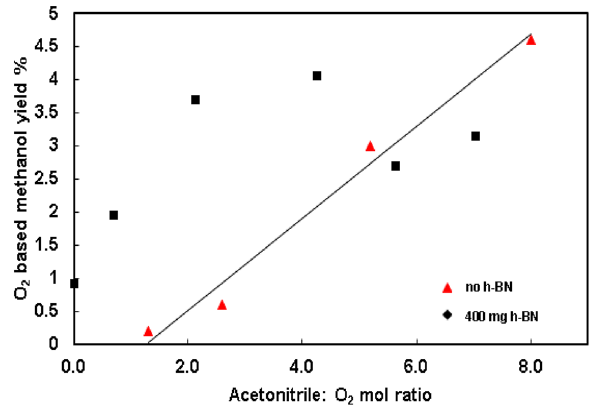
Figure 5. Variation of O 2 based methanol yield with acetonitrile: O 2 ratio and boron nitride loading. The graph does not illustrate 2.30: 1 h -BN to oxygen molar ratio, 8.2 MeCN: O 2 ratio reaction which resulted in 17% yield. All runs were conducted with the specified amount of BN, cold feed; 118 mmol of CH 4 , 7 mmol of O 2 , 163 mmol of He. The amount of acetonitrile was varied (0 mmol, 19 mmol, 28 mmol, 57 mmol, 76 mmol, 95 mmol) and heated to 275 °C, with no dwell time, and 60 rpm stirring.